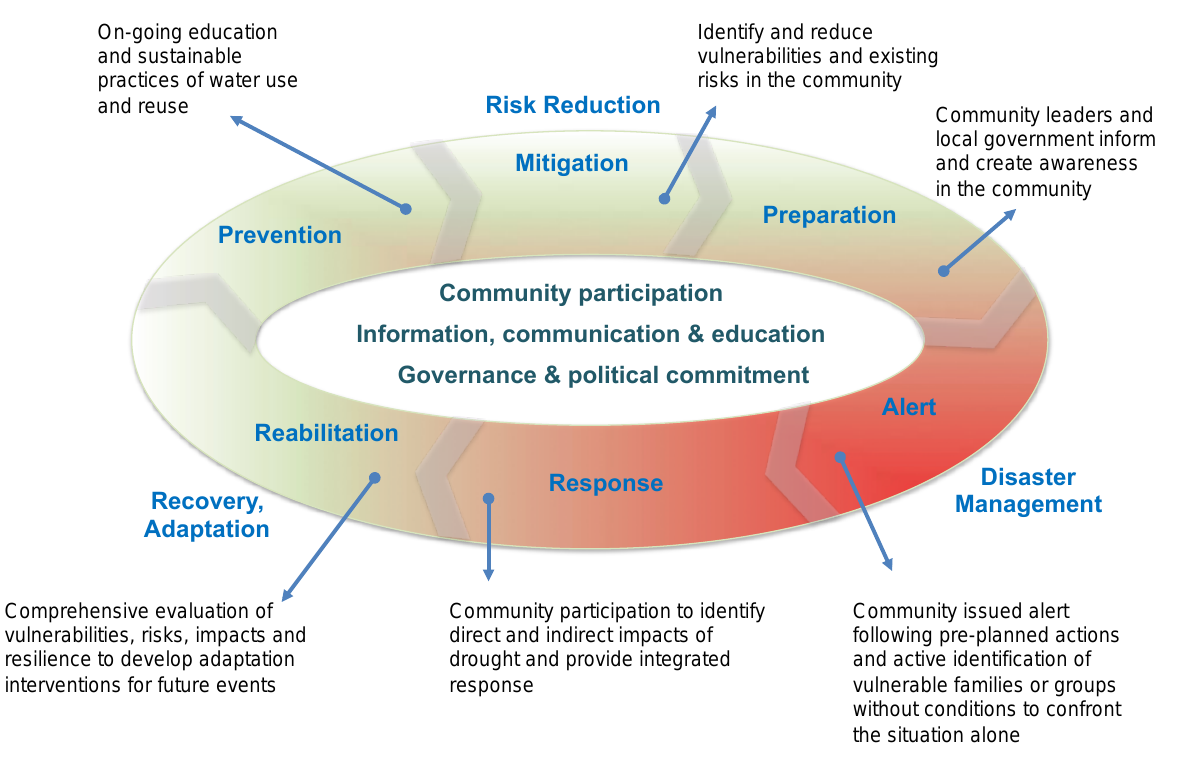
Figure 4. The role of the health sector in drought risk management. Framework with examples of community actions. Based on